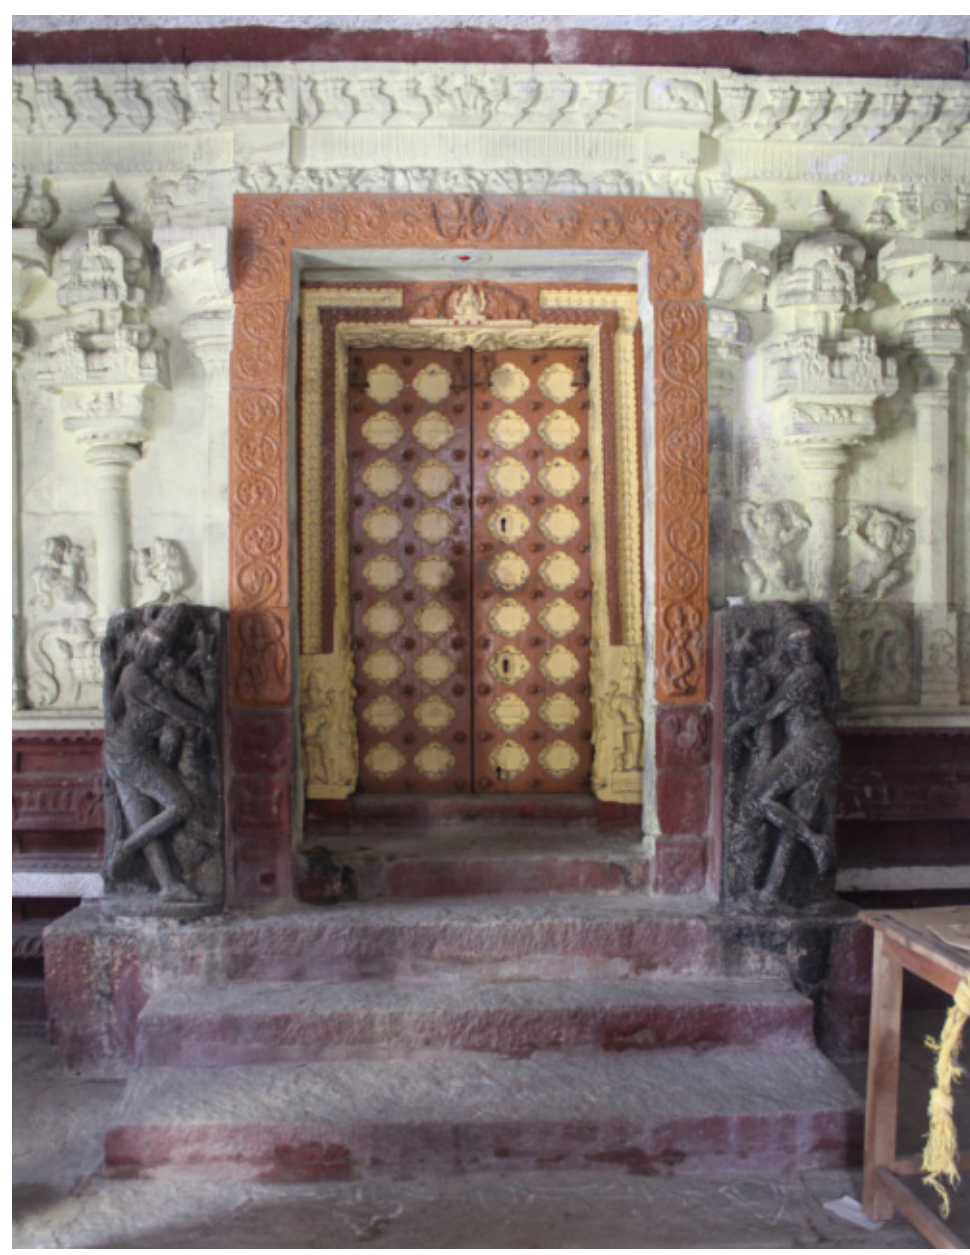
Figure 12. Door guardians, G ō ṅ ka ṇ ē svara temple, Kaveripakkam, Tamil Nadu. Photograph by Emma Natalya Stein.